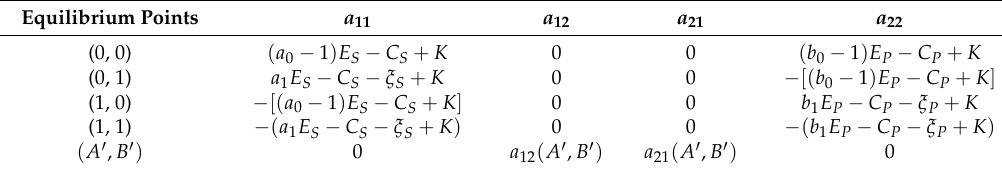
Table 5. Values of equilibrium points with an incentive mechanism.